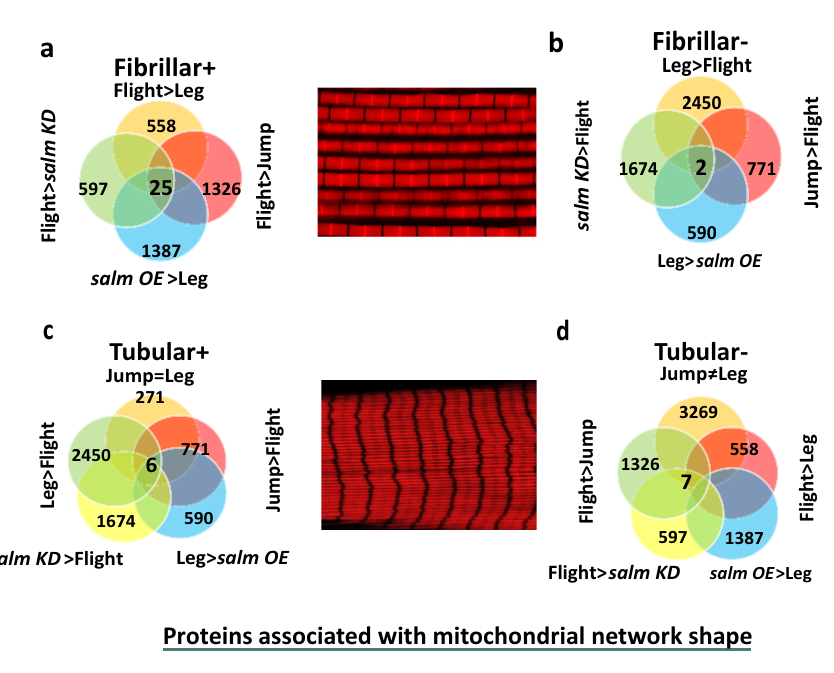
proteins, respectively. e , f Venn diagram for positively and negatively associated proteins, respectively,with parallelmitochondrialnetworks. g , h Venndiagramfor positively and negatively associated proteins, respectively, with grid-like mito- chondrialnetworks. i , j Venndiagramfor salm positivelyand negativelyassociated proteins,